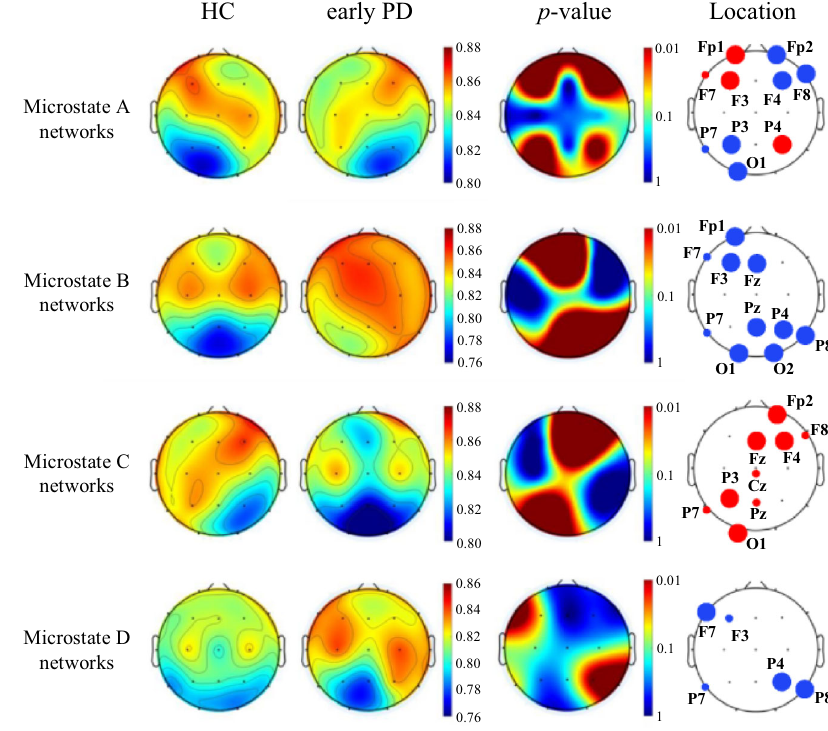
Fig. 2 Topological distribution of temporal variability. The red points indicate the positions in which the temporal variability of microstate functional connectivity networks in healthy controls are obviously higher than that in early PD patients, and the blue points represent the positions that have lower temporal variability in healthy controls. The large points represent signi fi cant group difference ( p < 0.01, FDR corrected), and the small points indicate p < 0.05 with FDR corrected.